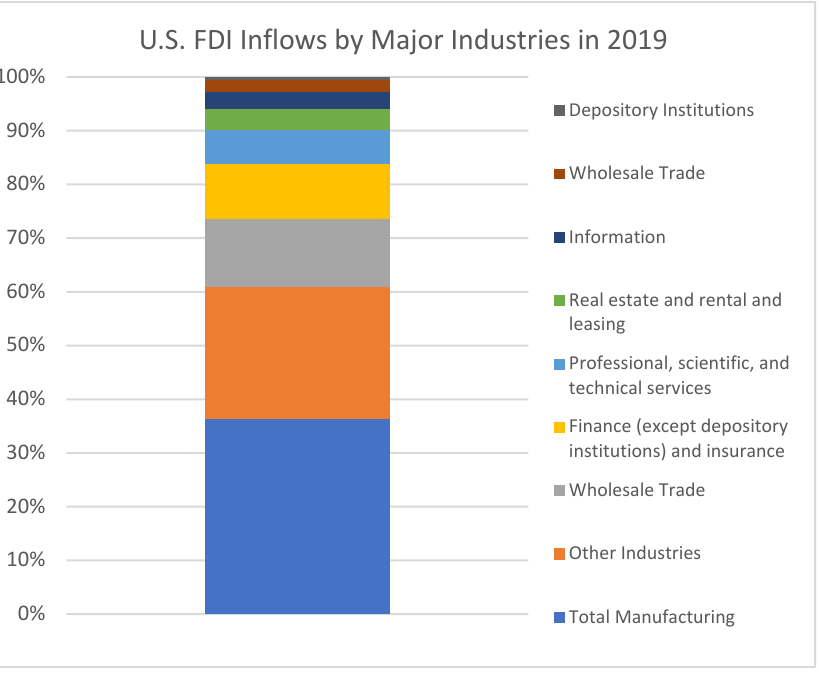
Figure 4. U.S. FDI Inflows by Major Industries in 2019 (Data source: U.S. Bureau of Economic Analysis).